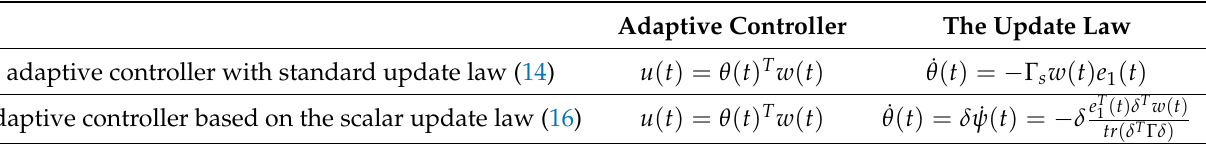
Table 1. The adaptive controllers and update laws in the standard MRAC and this paper.